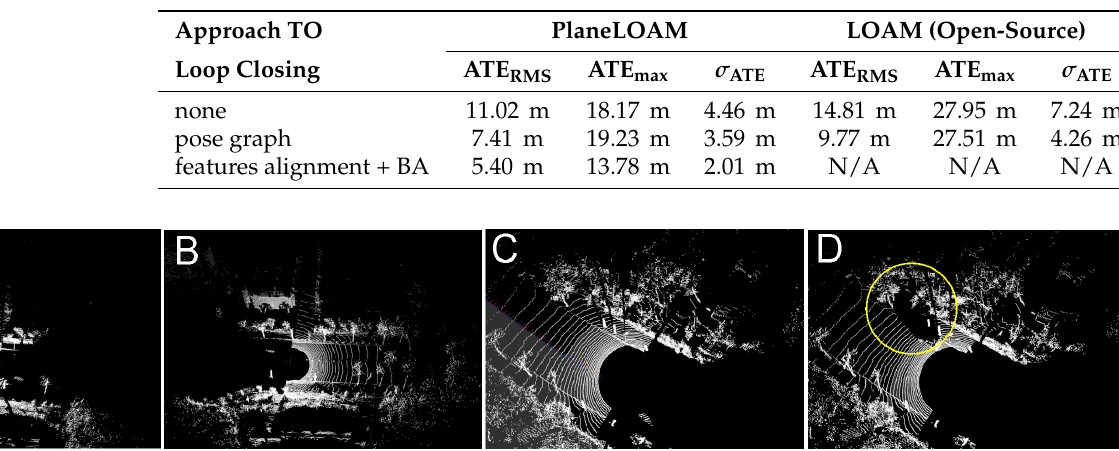
Table 5. Comparison of ATE errors for different approaches to loop closing on the MulRan DCC sequence.